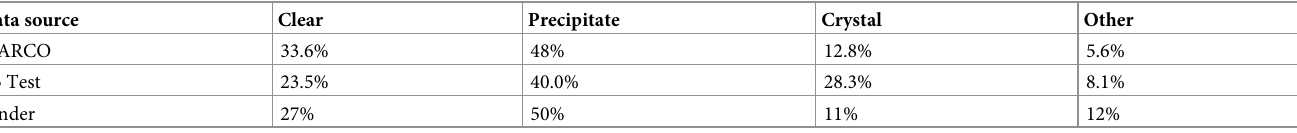
Table 1. Label distribution of different data sources.